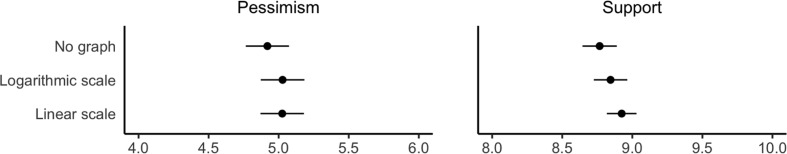
Mean Pessimism and Support in the Control and Treatment Groups